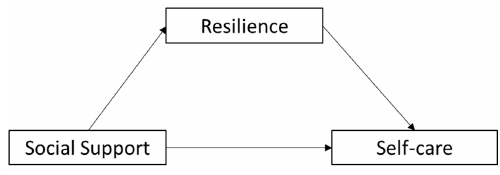
Figure 1. Hypothesized Model.